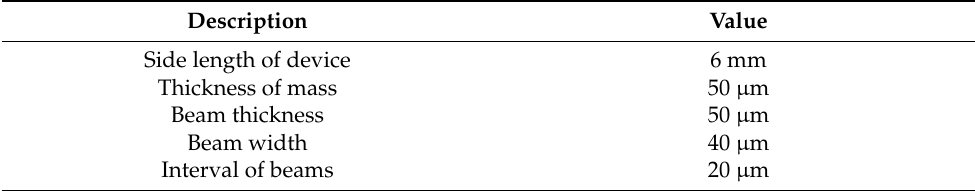
Table 2. Geometric parameters.